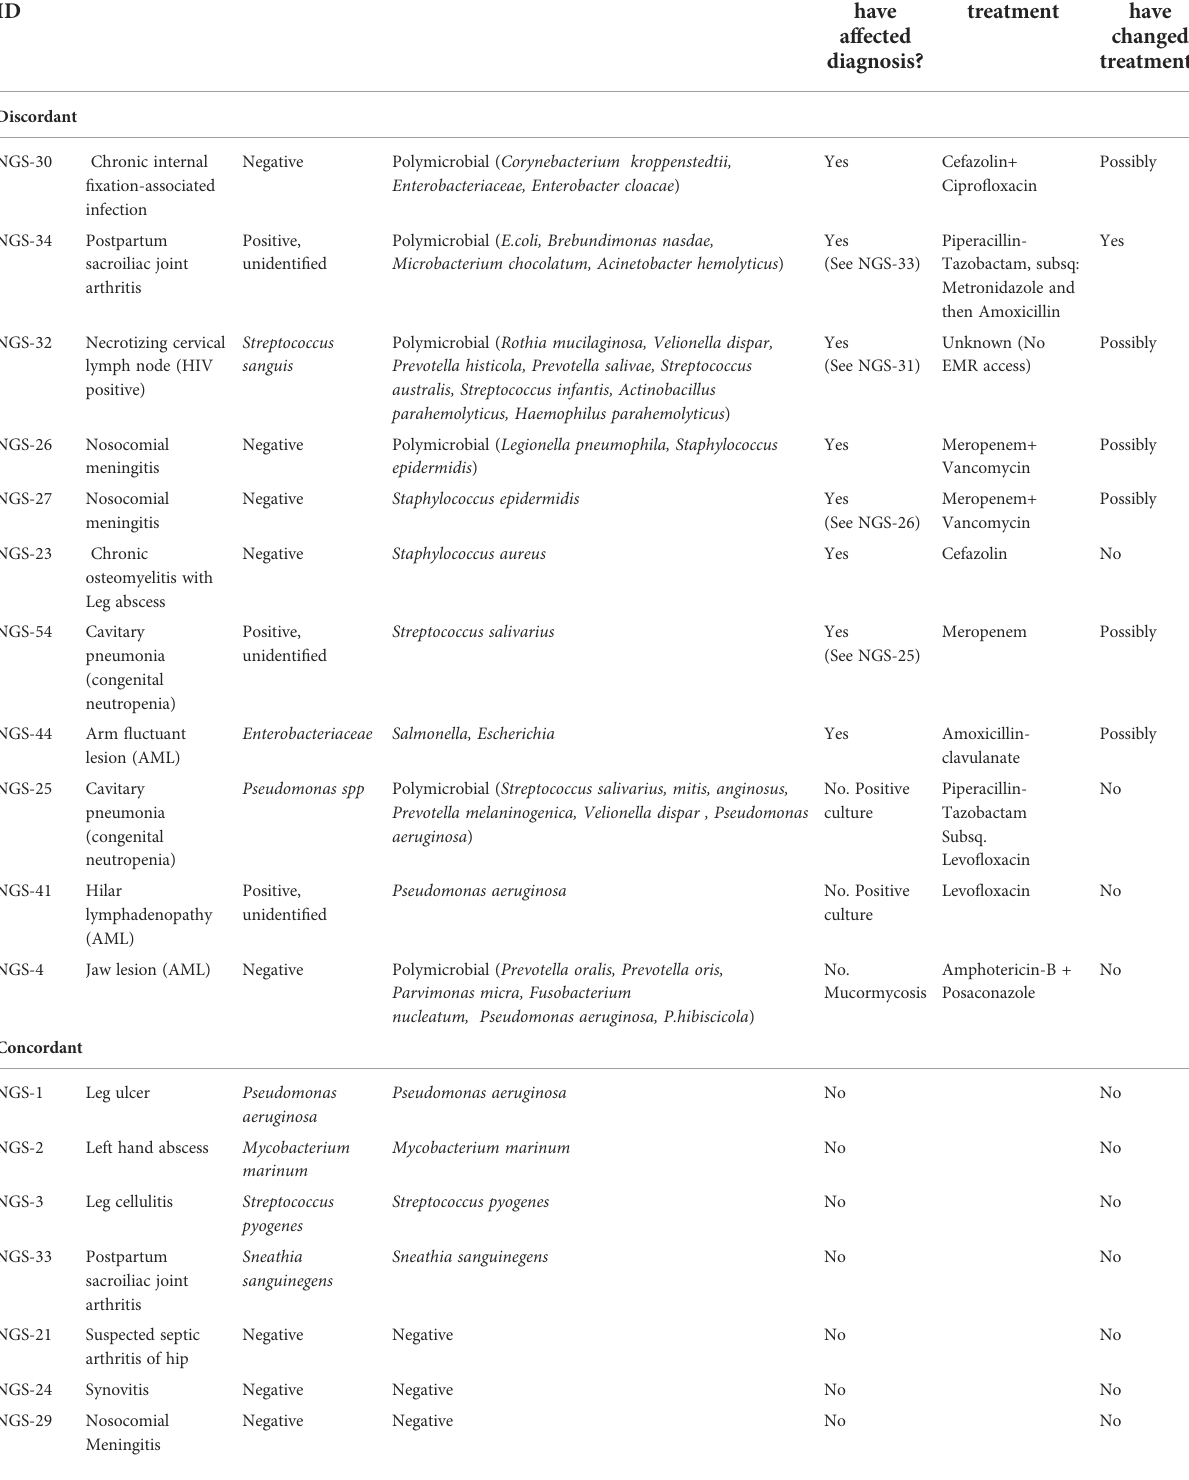
TABLE 2 Potential added value of NGS over Sanger for patient